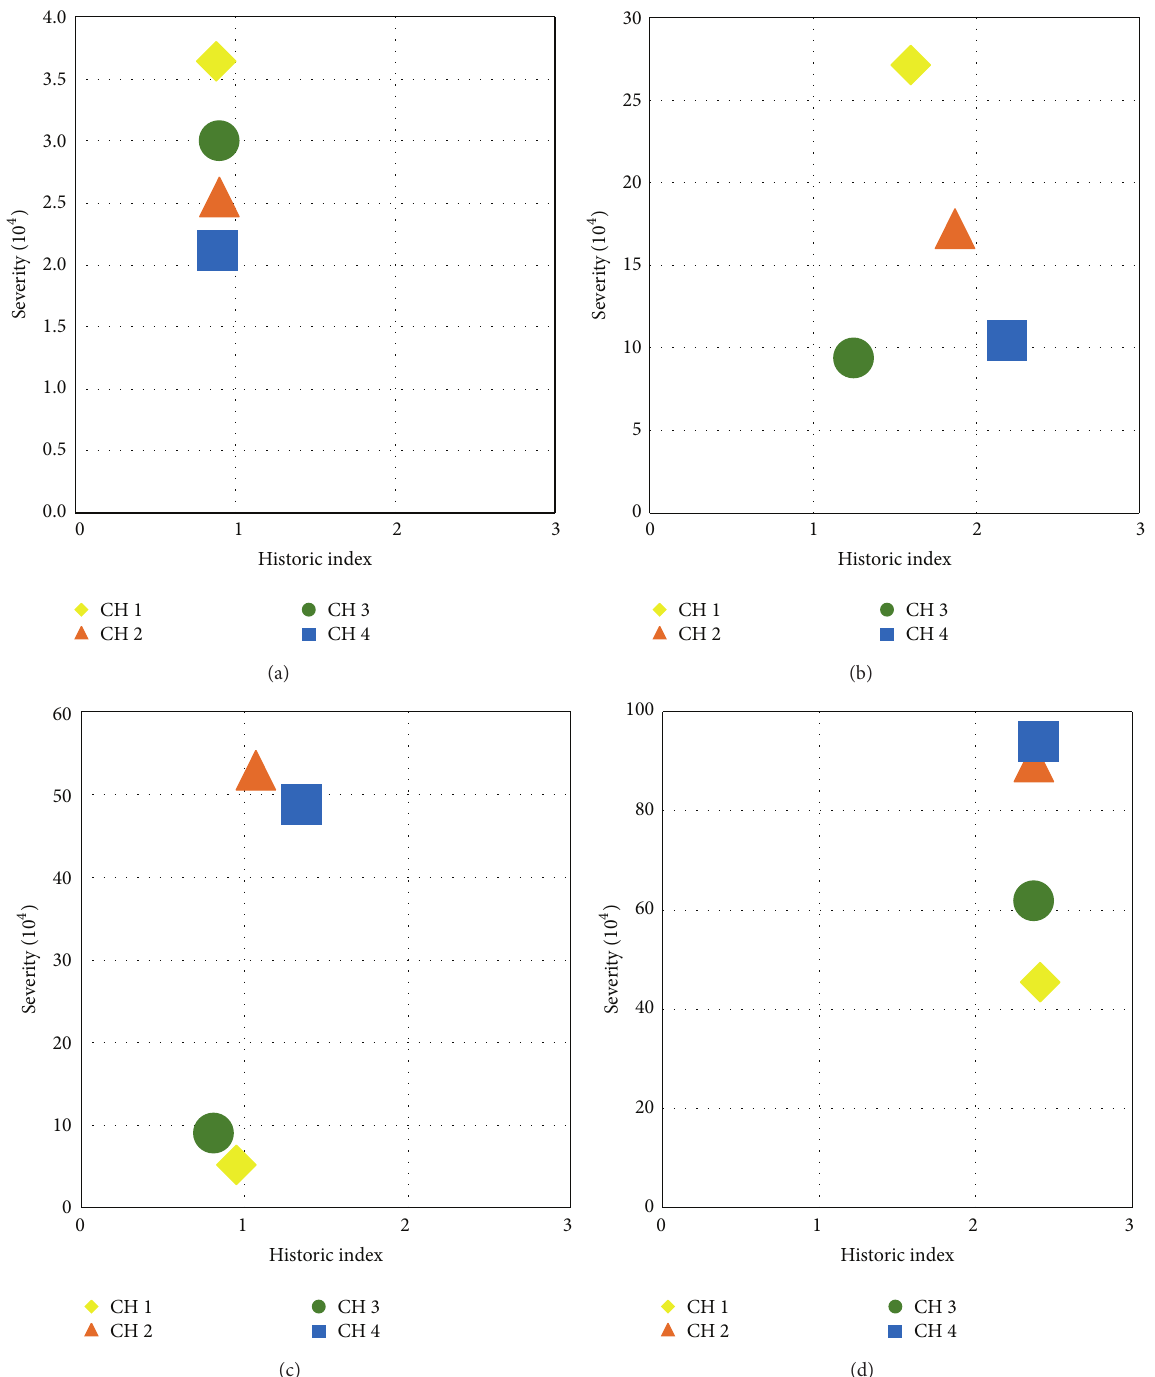
Figure 10: Intensity chart for double cell specimen at each stage of damage. (a) Stage I, (b) stage II, (c) stage III, and (d) stage IV.